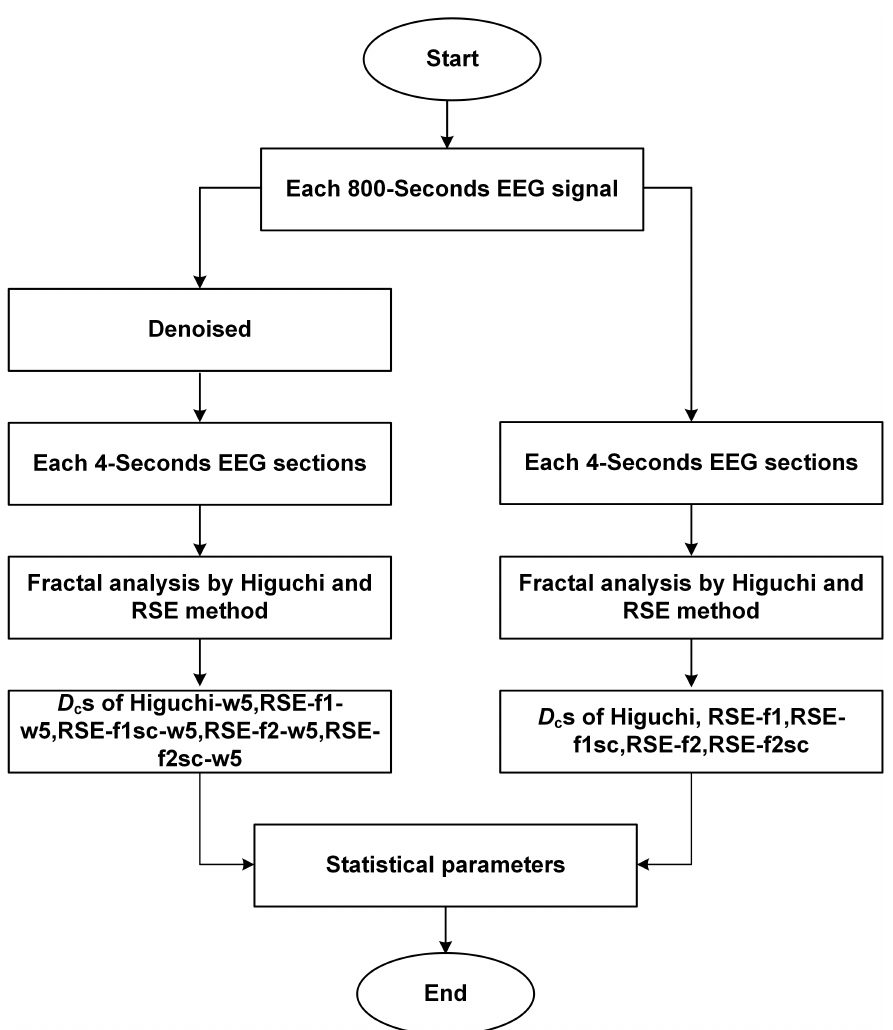
Figure 1. The calculation flowchart of fractal analysis on epileptic EEG